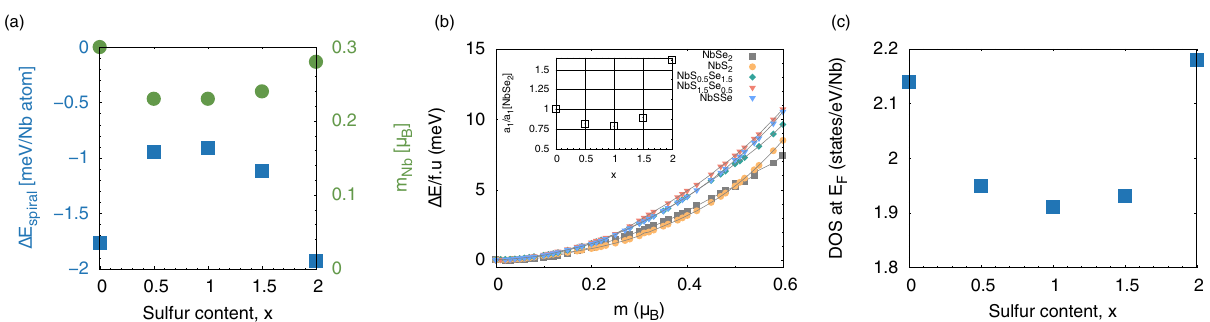
Fig. 3 Electronic and magnetic properties of the NbS x Se 2 − x alloys. a Energy difference between the spin spiral state and the non magnetic state as a function of sulfur content, x , in NbS x Se 2 − x (blue fi lled squares, left vertical axis). Magnetic moment per Nb atom as a function of sulfur content in the spin spiral calculation with fi nite q (green circles, right vertical axis). b Collinear fi xed-spin moment calculations of NbSe 2 (gray squares), NbS 2 (orange circles), NbS 0.5 Se 1.5 (teal diamonds), NbSSe (red downward triangles), and NbS 1.5 Se 0.5 (blue triangles) illustrate the change in energy per formula unit with respect to the non-magnetic state as a function of magnetic moment per Nb atom. The inset illustrates the coef fi cient a 1 (see main text) normalized by the value of a